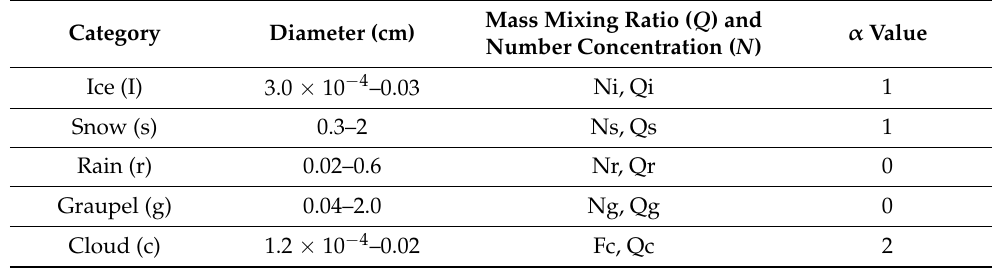
Table 1. Water substance categories and their α values included in the CAMS scheme.